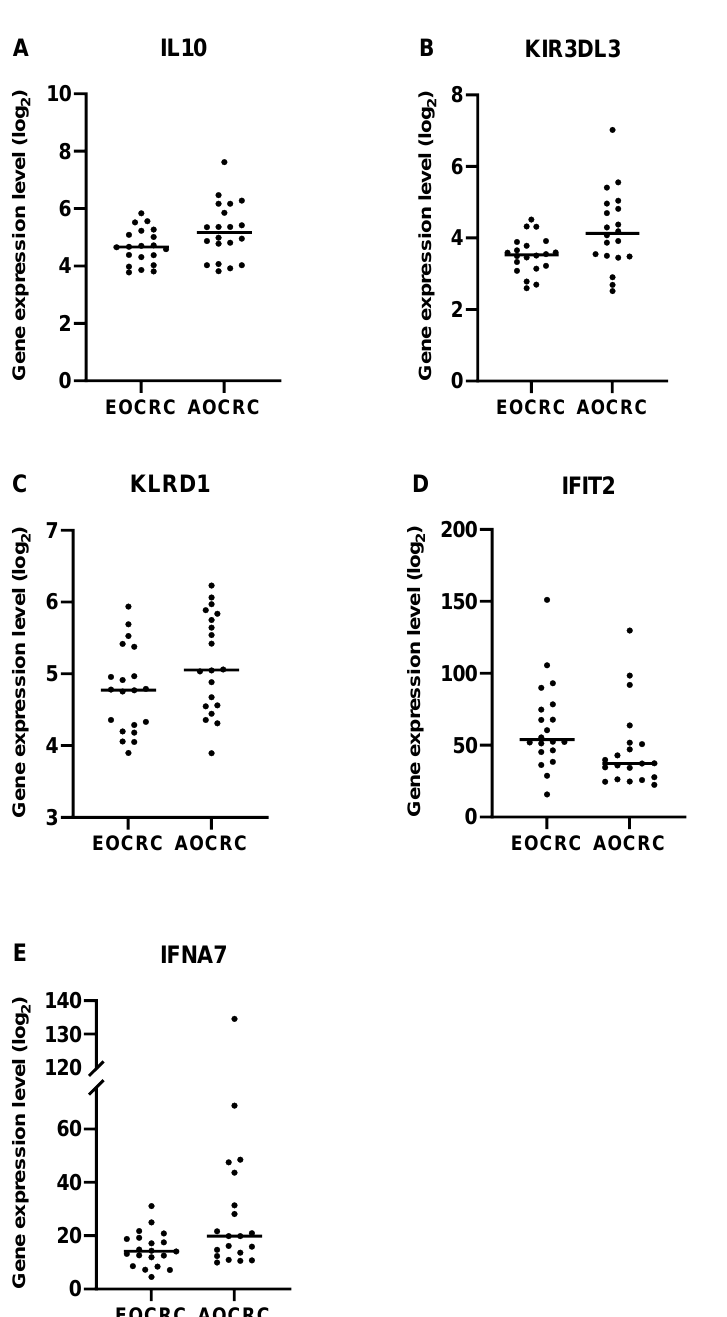
Figure 5. Gene expression in early and average-onset CRC. Significantly different expression in EOCRC and AOCRC in the three preselected gene panels are illustrated. Regulatory panel; ( A ) IL10 p = 0.0499, Cytotoxicity panel; ( B ) KIR3DL3 p = 0.0315 and ( C ) KLRD1 p = 0.0499, Pro-inflammatory panel; ( D ) IFIT2 p = 0.0167 and ( E ) IFNA7 p = 0.0439. Symbols show individual values, and lines indicate the median.